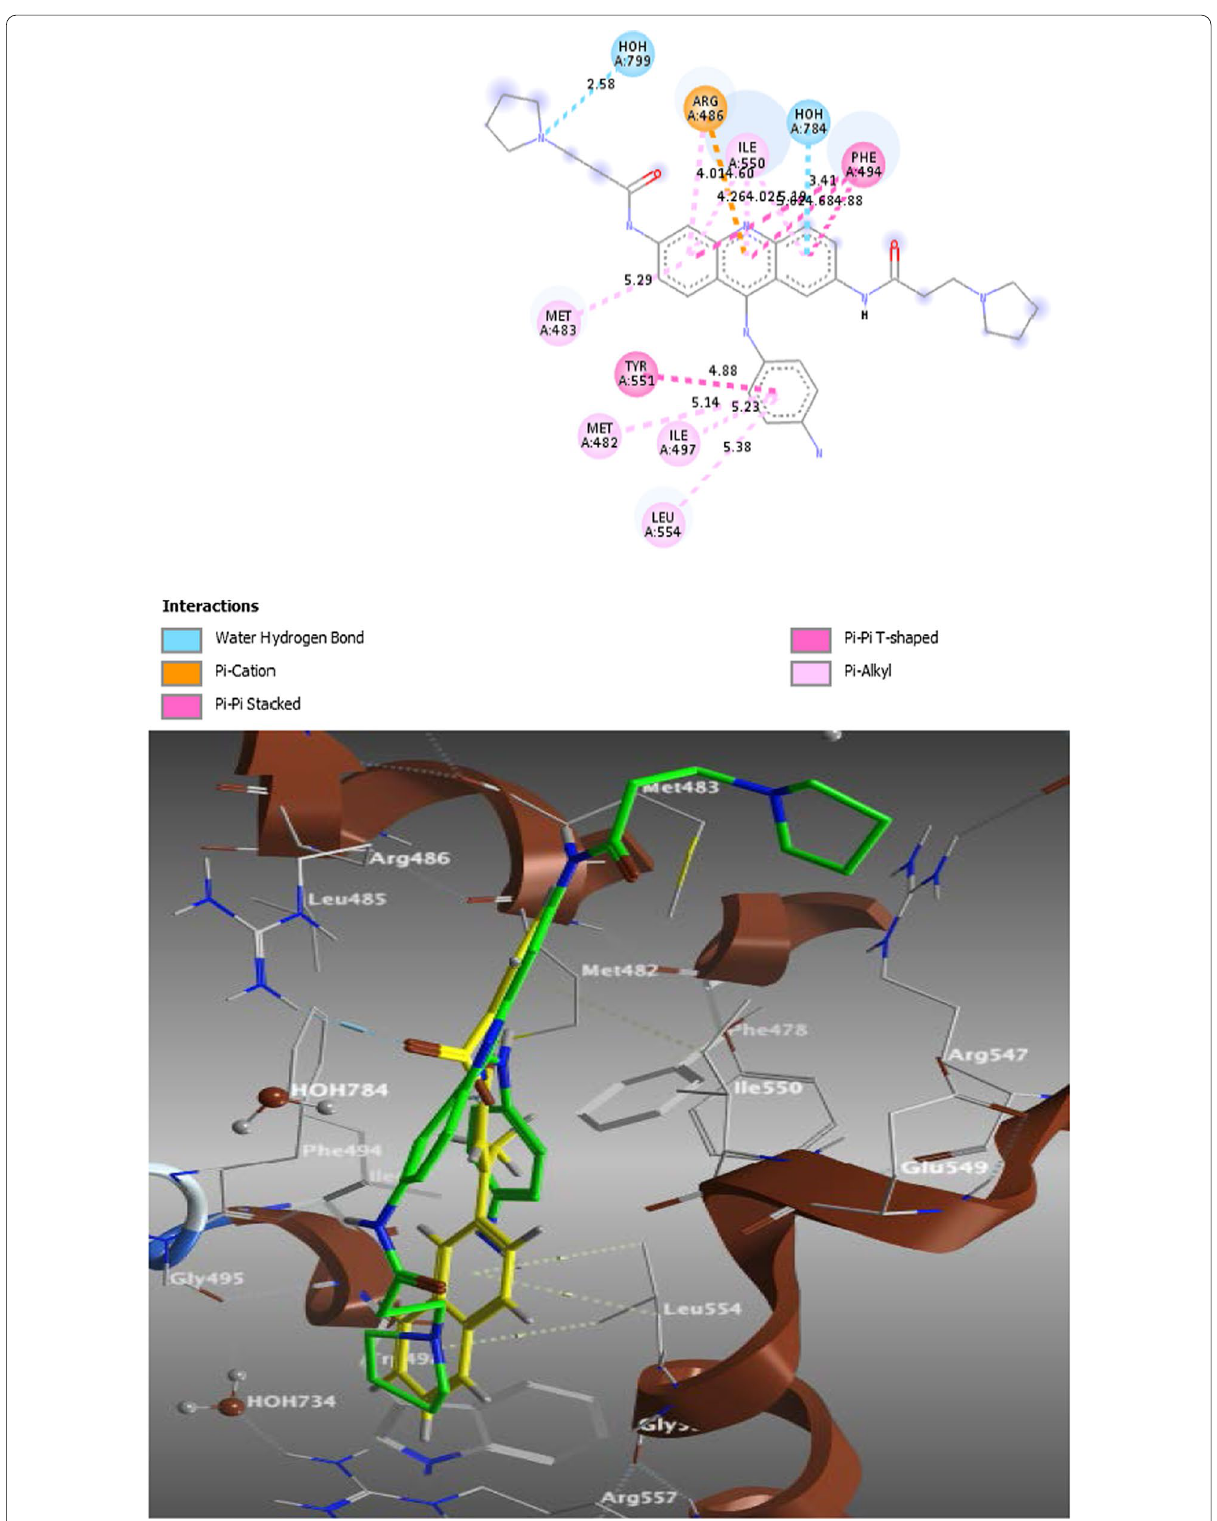
Fig. 15 Depiction of 2D interaction of pose 3 of compound 82 and 3D presentation of superimposed alignment of pose 3 of compound 82 with